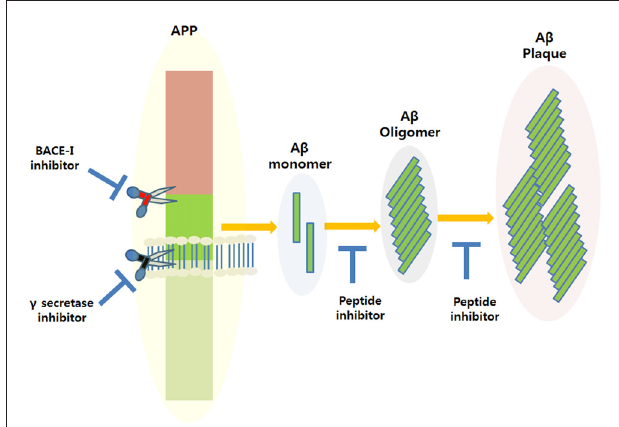
FIGURE 1 | Amyloidogenic amyloid precursor protein (APP) processing and the possible applications of peptide inhibitors to prevent amyloid-beta (A β ) plaque formation at different disease